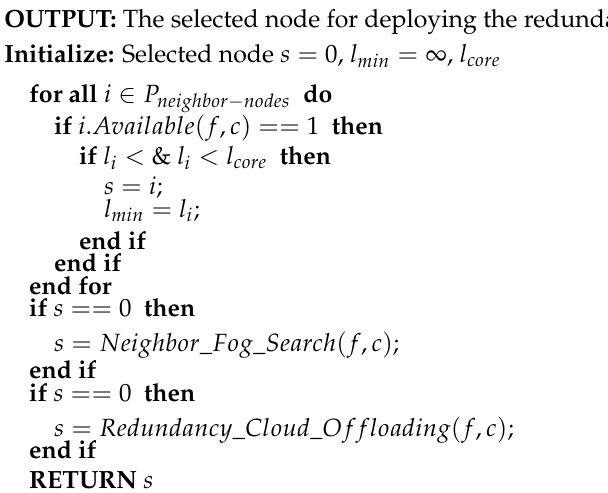
Algorithm 3 A Collaborative Redundancy Deployment Scheme for VNFs at the Fog